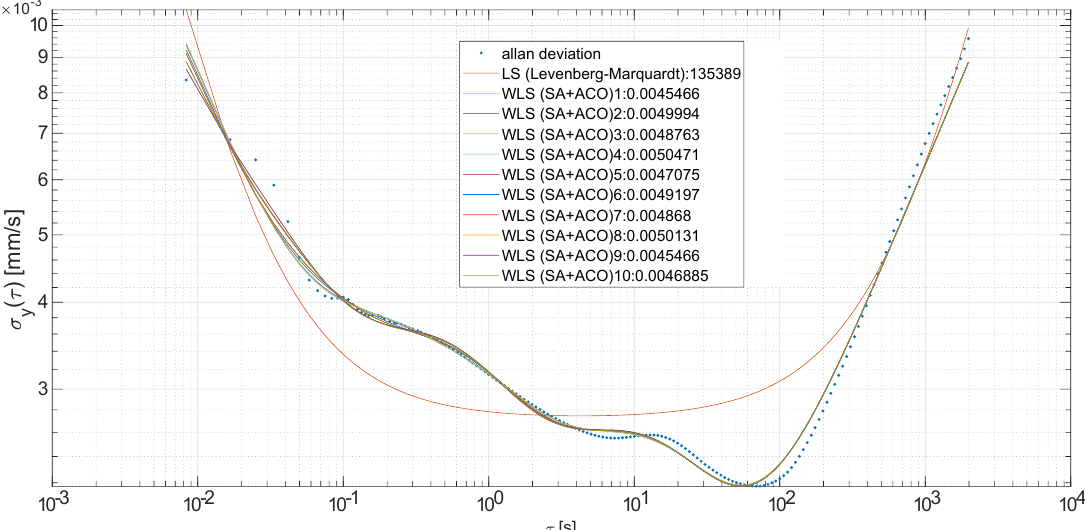
Figure 6. Regression results for an excerpt from the experimental data, demonstrates complex ADEV curve with periodic and correlated components and 10 starts of WLS compared with ordinary